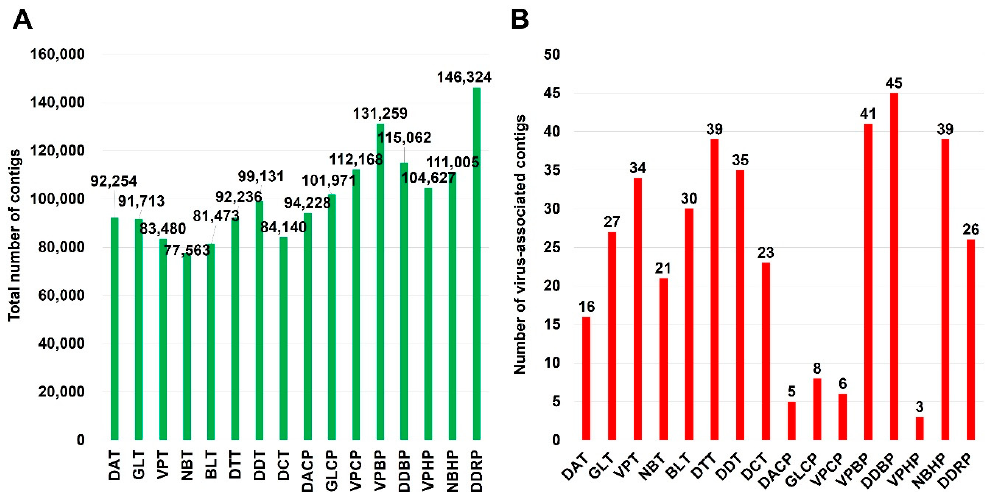
Figure 2. Number of assembled contigs and virus-associated contigs. ( A ) The total number of contigs assembled by Trinity program in each library. ( B ) The number of virus-associated contigs in each library, which was identified by BLASTN search against viral genome